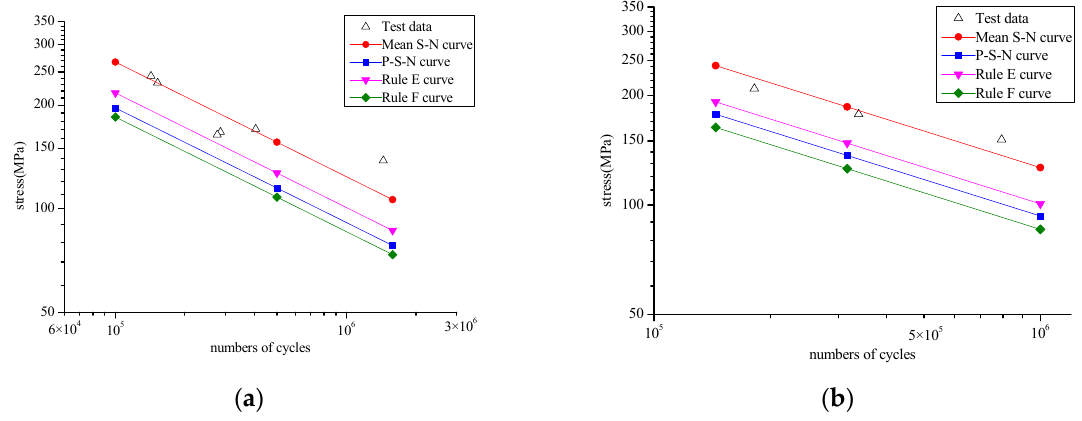
Figure 8. Fixed-slope S-N curves as follows: ( a ) Model 1 and ( b ) Model 2.